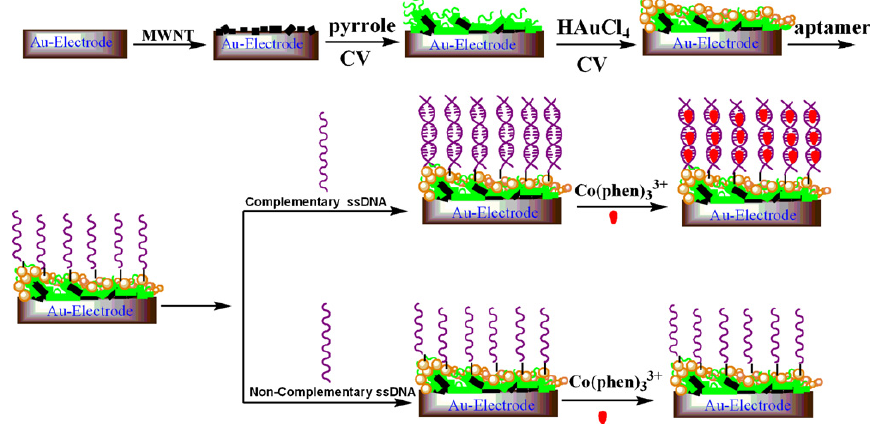
Fig. 1. A schematic diagram depicting the experimental procedures. Figure 19. A schematic diagram showing experimental procedure of DNA aptamer